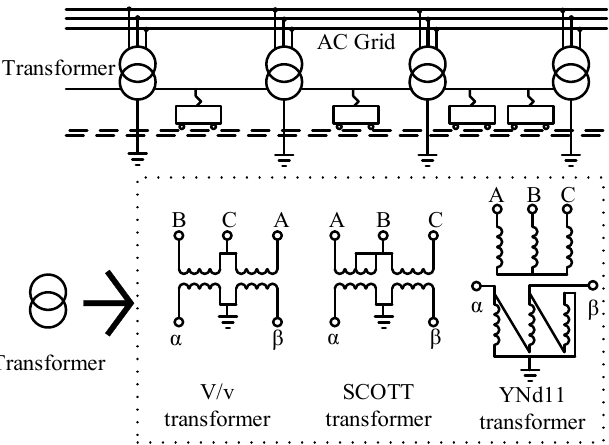
Figure 3. The typical AC traction power network with multi-trains.